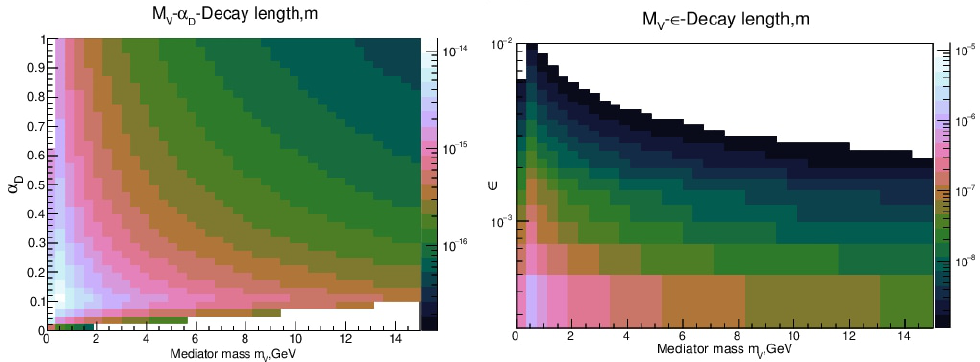
Figure 4. Dependence of the dark photon mean free path from its production to its decay into an LDM pair (left) and a µ − µ + pair (right) on the dark photon mass and parameters α D and (cid:101)